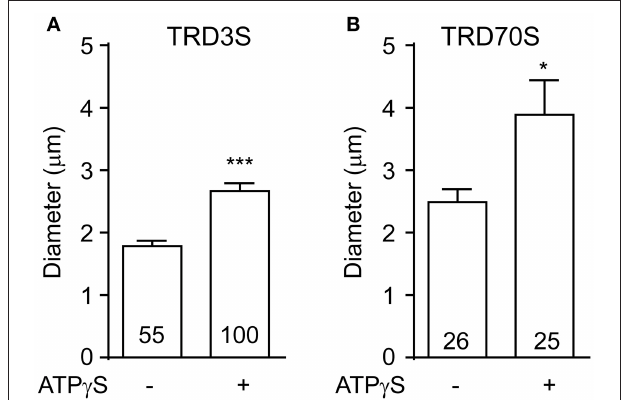
FIGURE 3 | ATP γ S stimulation increased the vesicle size of macropinosomes. The diameter of macropinosomes were analyzed at 1.5h after TRD3S (A) or TRD70S (B) injected. P -values of significance (indicated with asterisks, * p < 0.05, *** p < 0.001) were calculated using student t